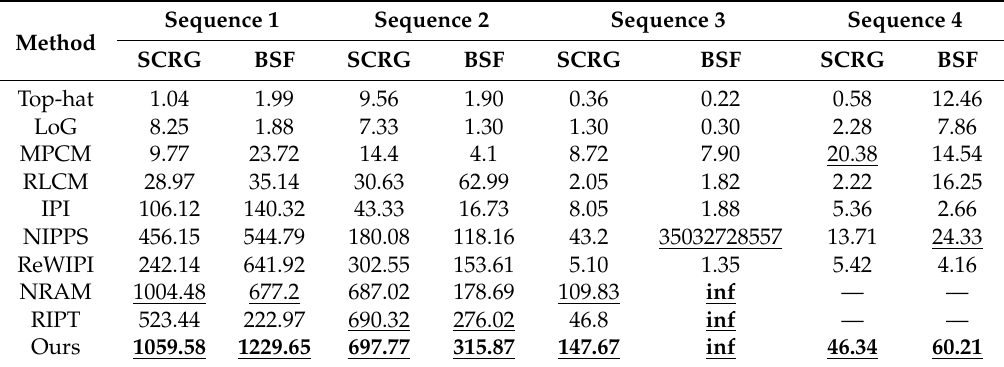
Table 5. SCRG and BSF values of the ten methods.